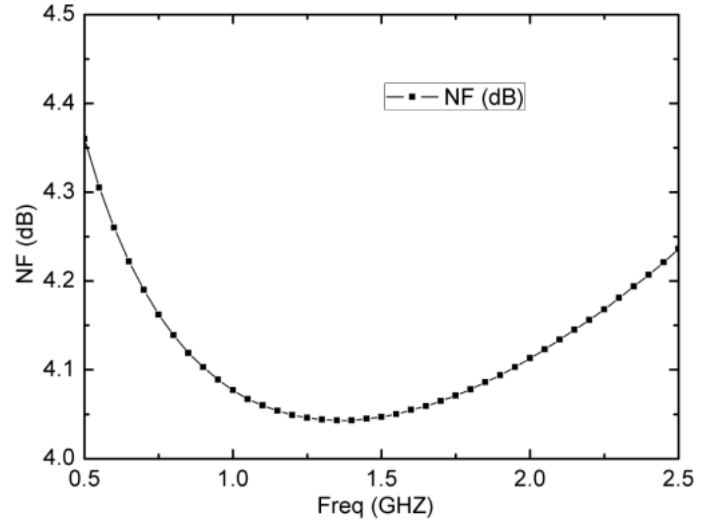
Figure 9. Simulated noise figure of the wideband LNA.